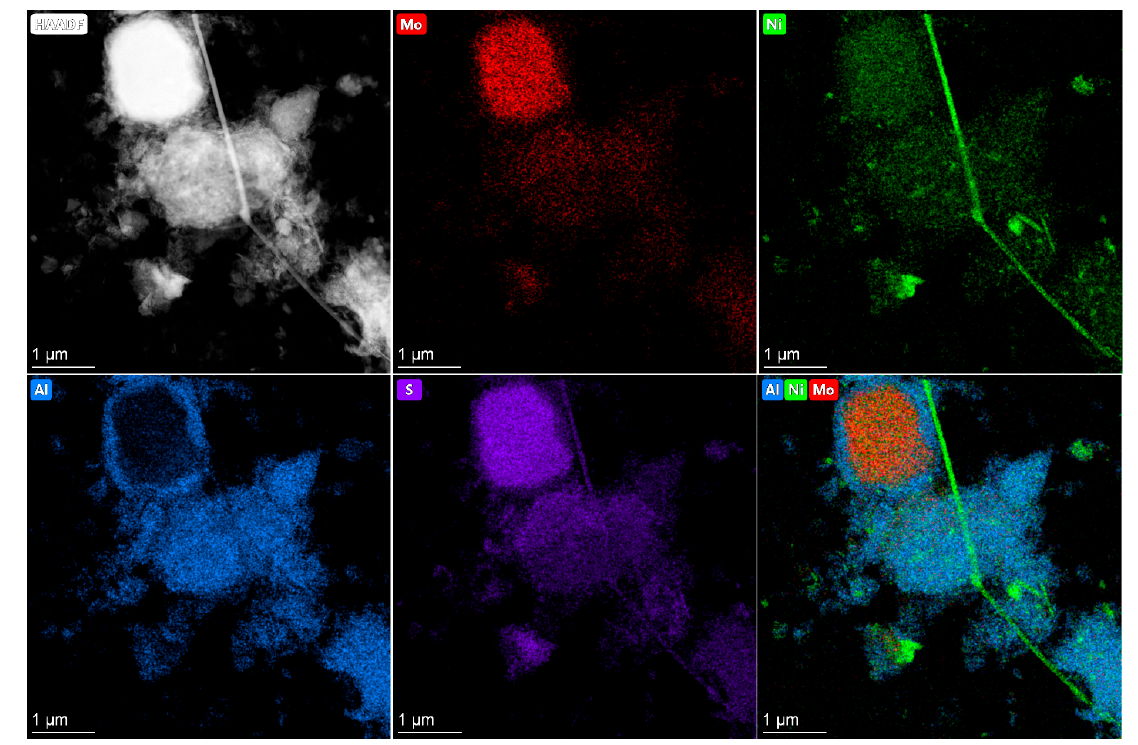
Figure 5. HAADF data on the c—Ni 1 Mo 1 sulfide catalyst after testing.